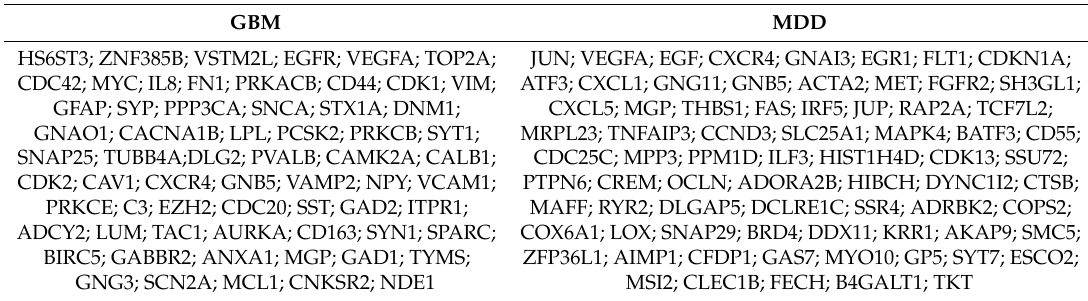
Table 2. MDD and GBM Hub genes.